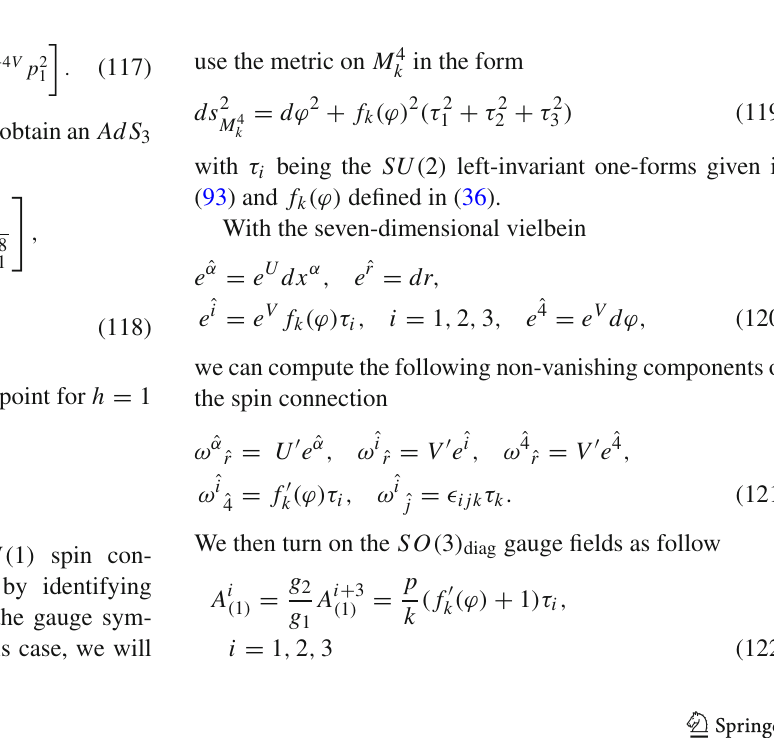
Fig. 13 An RG flow from SO ( 3 ) N = ( 1 , 0 ) SCFT in six dimensions to two-dimensional N = ( 2 , 0 ) SCFT with SO ( 2 ) diag symmetry dual to AdS 3 × CH 2